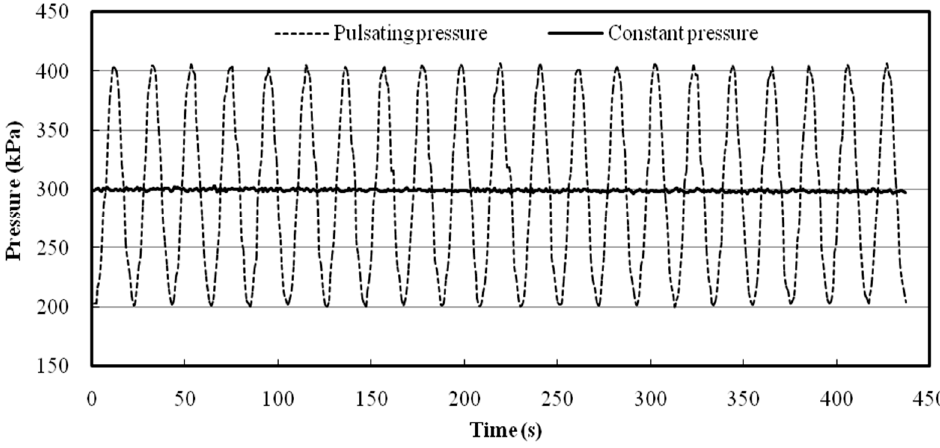
Figure 2. The measured constant pressure and pulsating pressure versus time.